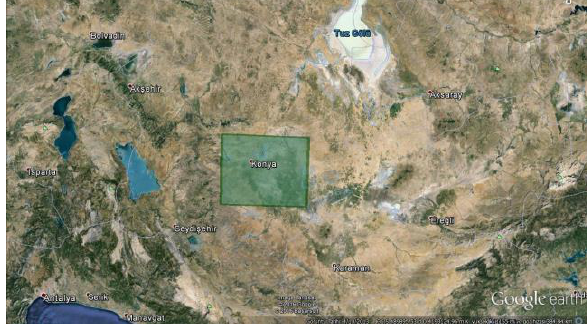
Figure 1. A Map about Test Area